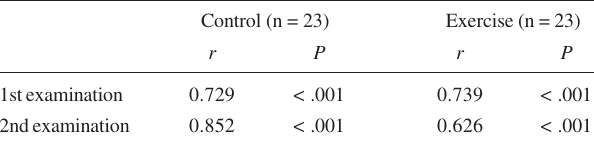
Table 6 - Spearman correlation coefficients for functional evaluation of the pelvic floor (FEPF) and perineometry without biofeedback (PWB) obtained at the first and second examinations (HCFMUSP, November 2003 to December 2004).